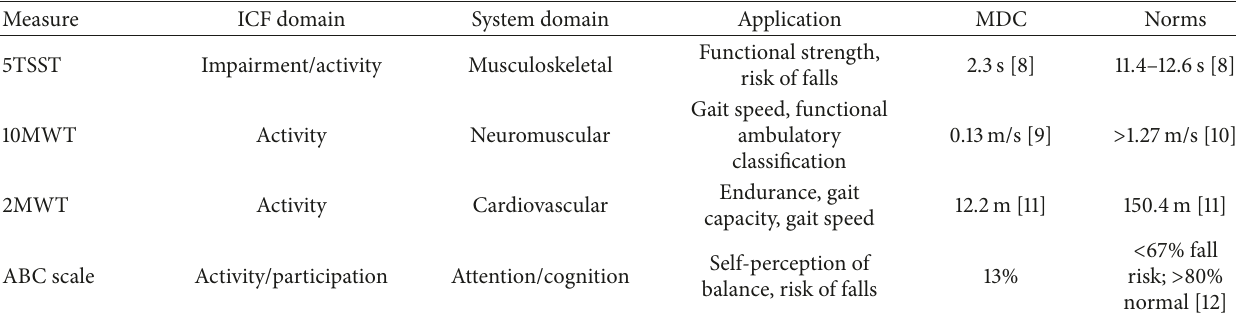
Table 1: Selected outcome measures and related